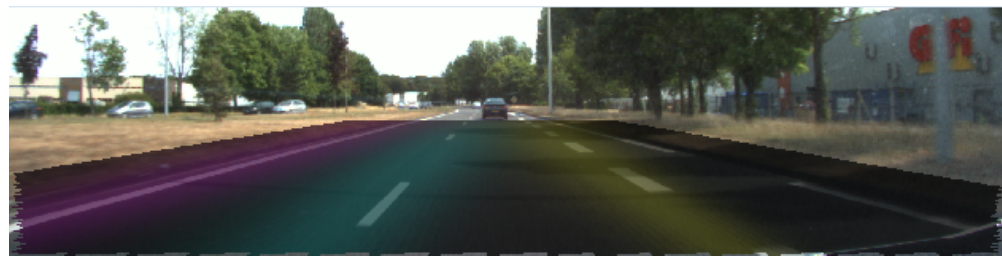
Figure 14. Resultant grids of the evidential approach, small position uncertainty ( σ x = 0.2 m, σ y = 0.3 m, σ θ = 0.1 radians )